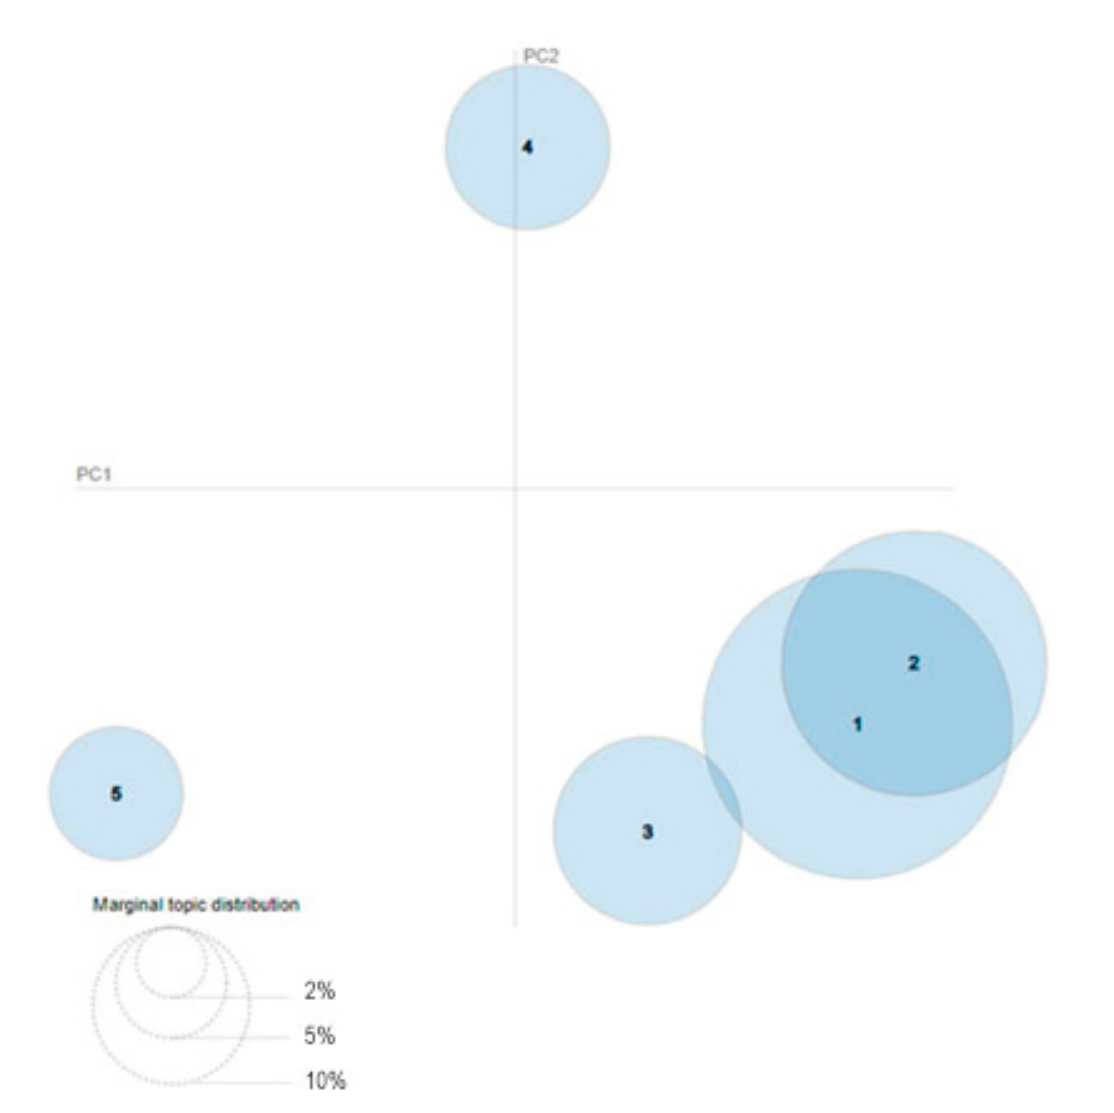
Figure 3. Intertopic distance map. The figure shows the relative position and size of five main topics in the area of cultured meat on the social network